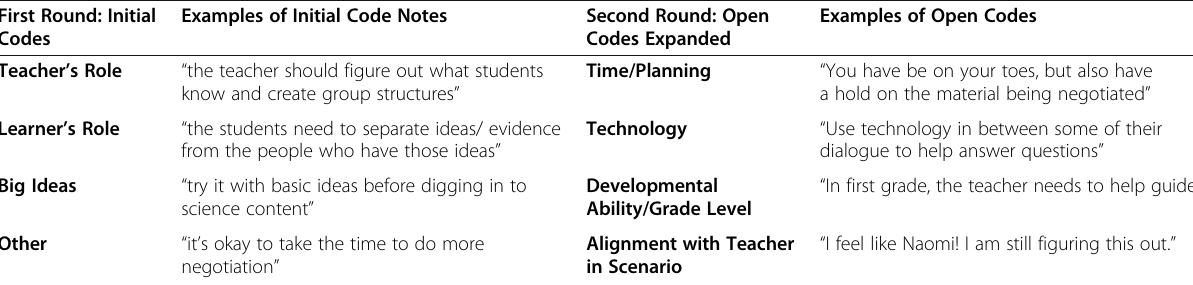
Table 2 Thematic Coding of Vignette Responses First Round: Initial Codes